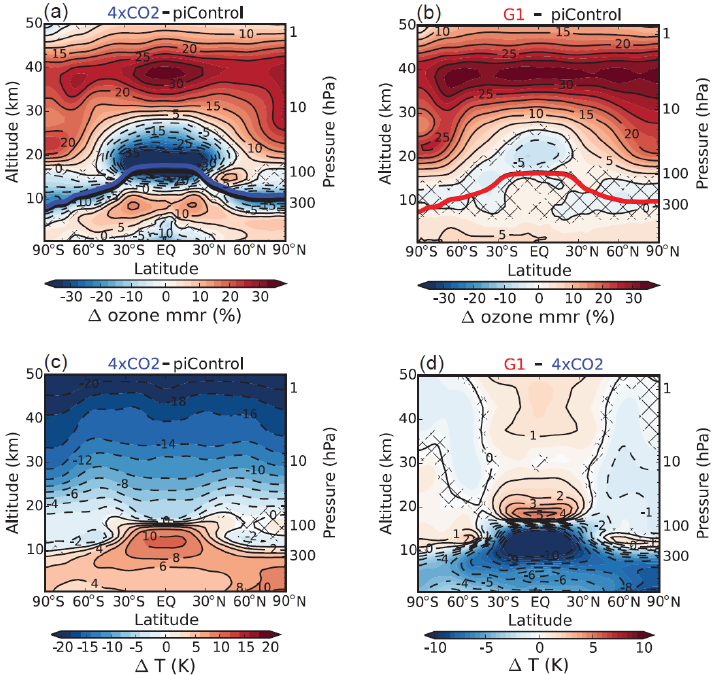
Figure 3. Differences in zonal and annual mean ozone mass mixing ratio and temperature. (a, b) Percentage differences in ozone as labelled. (c, d) Temperature differences (K) as labelled. Note that (d) shows the difference between G1 and 4 × CO 2 , i.e. not the changes relative to piControl, in contrast to (a) – (c) , and that a different colour scale is used than in (c) . The ozone changes are given in percentages to highlight in terms of absolute mass mixing ratios the much smaller changes in the ozone-poor troposphere as compared to the larger absolute changes in the stratosphere, which in turn occur on much higher background ozone levels. The colour scale for ozone is adapted to changes in the middle-upper stratosphere; for the whole extent of the changes in the tropical upper troposphere and lower stratosphere under 4 × CO 2 , see Nowack et al. (2015). Differences are calculated on altitude levels, the pressure axis gives approximate values for pre-industrial conditions. Coloured lines in (a, b) mark the zonal and annual mean tropopause heights for each experiment. Non-significant differences (using a two-tailed Student’s t test at the 95% confidence level) are crossed out.